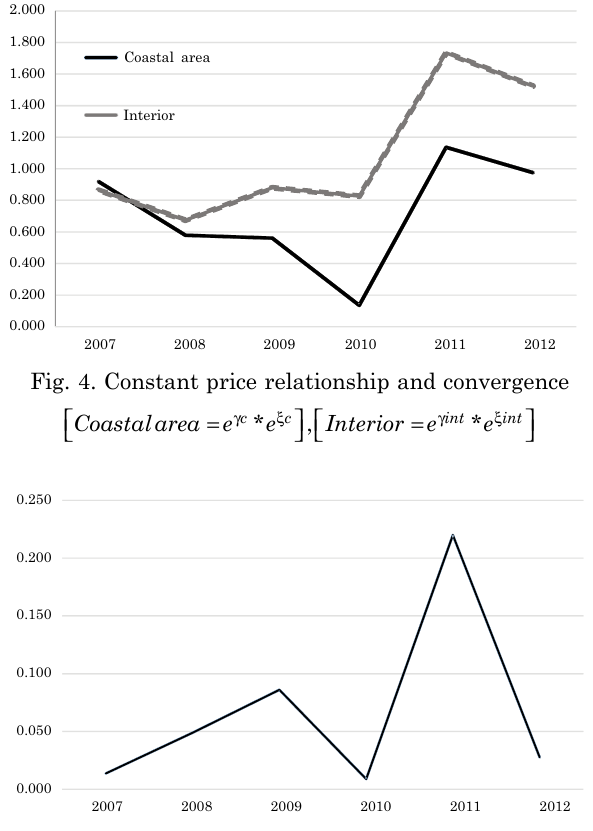
Fig. 5. Constant relationship and convergence. ‘k’ value for the conditional model’s